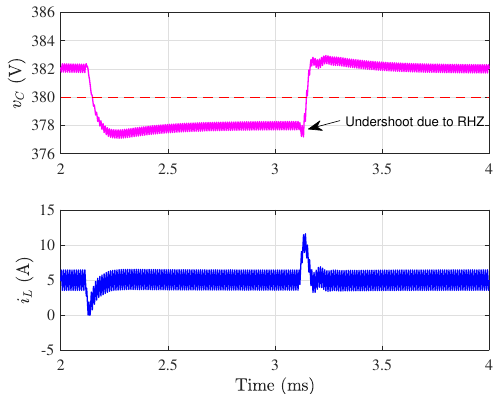
Figure 15. Small-signal transient response in front of a 4 V step change between 378 V and 382 V in ± the reference voltage from numerical simulations using a detailed switched model implemented in PSIM c (cid:13) and the discrete-time model showing a non-minimum phase